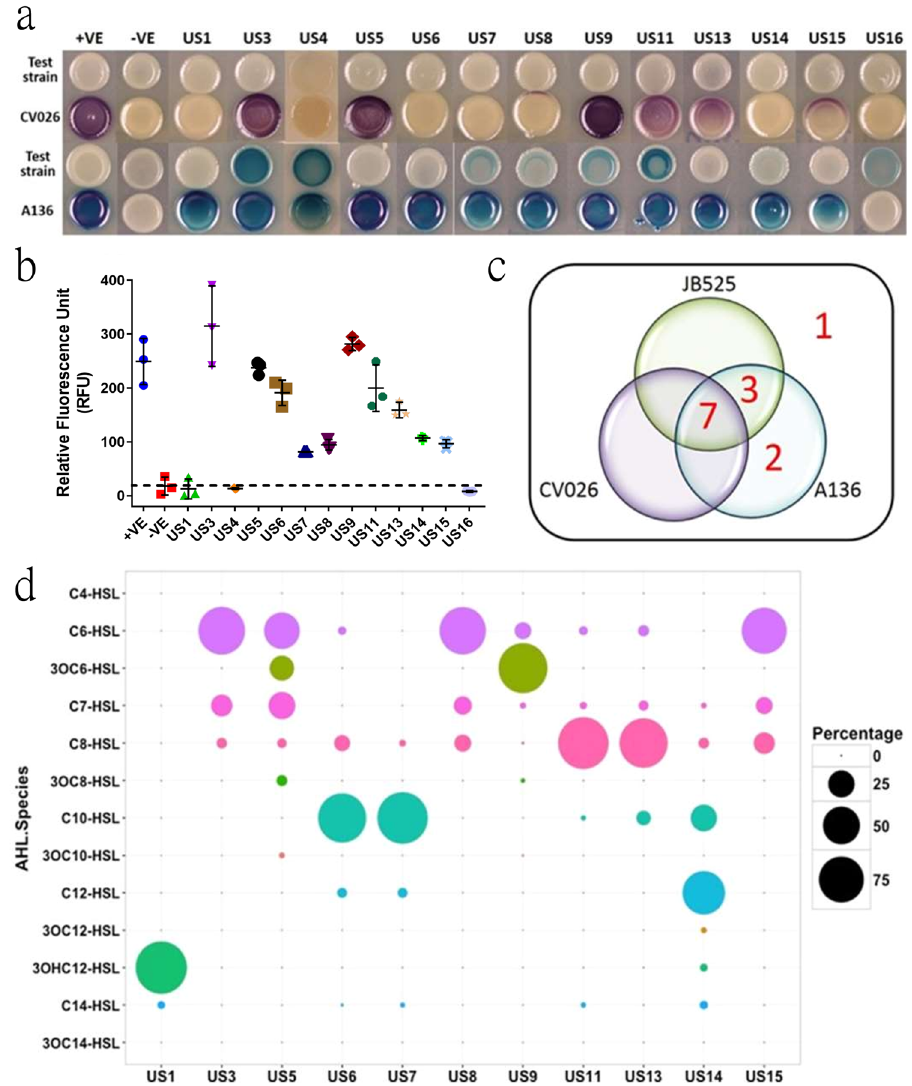
Fig. 1 Heterologous expression of metagenomic luxI homolog genes recovered from Ulu Pandan sludge microbial community in Escherichia coli Top10. Detection of AHLs synthesized by different metagenomic luxI clones using AHL sensitive biosensors Chromobacterium violaceum CV026 and Agrobacterium tumefaciens A136 ( a ) or E. coli JBA525 ( b ). Distribution of metagenomic luxI clones according to their capacity to activate different AHL-sensitive biosensors ( c ). Chemical characterization and quanti fi cation of AHL species using HPLC – MSMS ( d ). The relative quantity of different AHL species synthesized by the individual clone is indicated by the bubble size. US: Ulu Pandan Synthase (Metagenomic luxI clone); + VE: positive control; − VE: negative control. Data are presented as mean ±